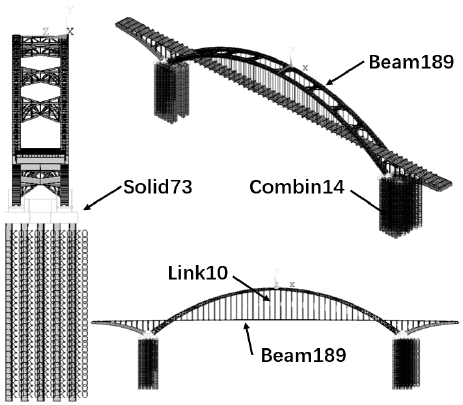
Fig. 5. The finite element model of